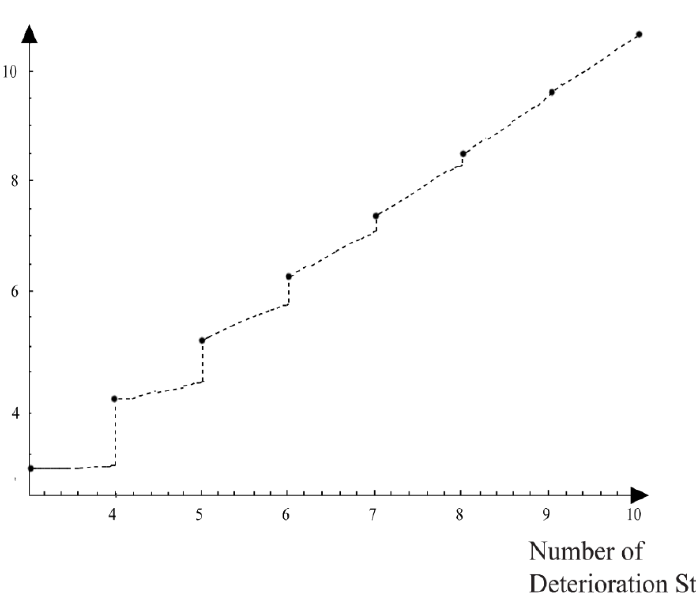
Figure 3. Mean failure time in the two-unit parallel redundant system with deterioration on 𝑛 × 𝑛 lattice.